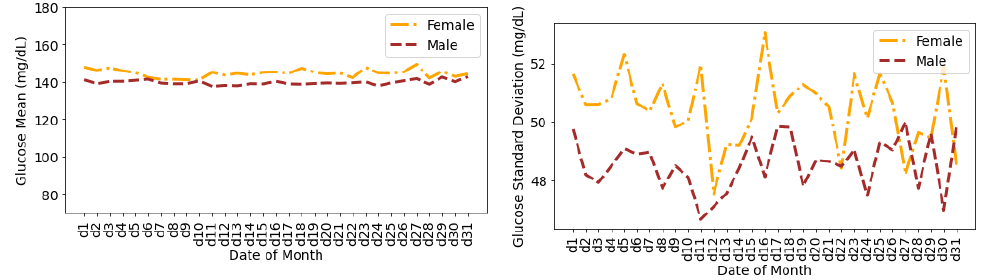
Figure 9. Average glucose mean and standard deviation for insulin-requiring individuals in OpenAPS Data Commons dataset during days of a month based on gender. Total number of males and females is 50 and 28,